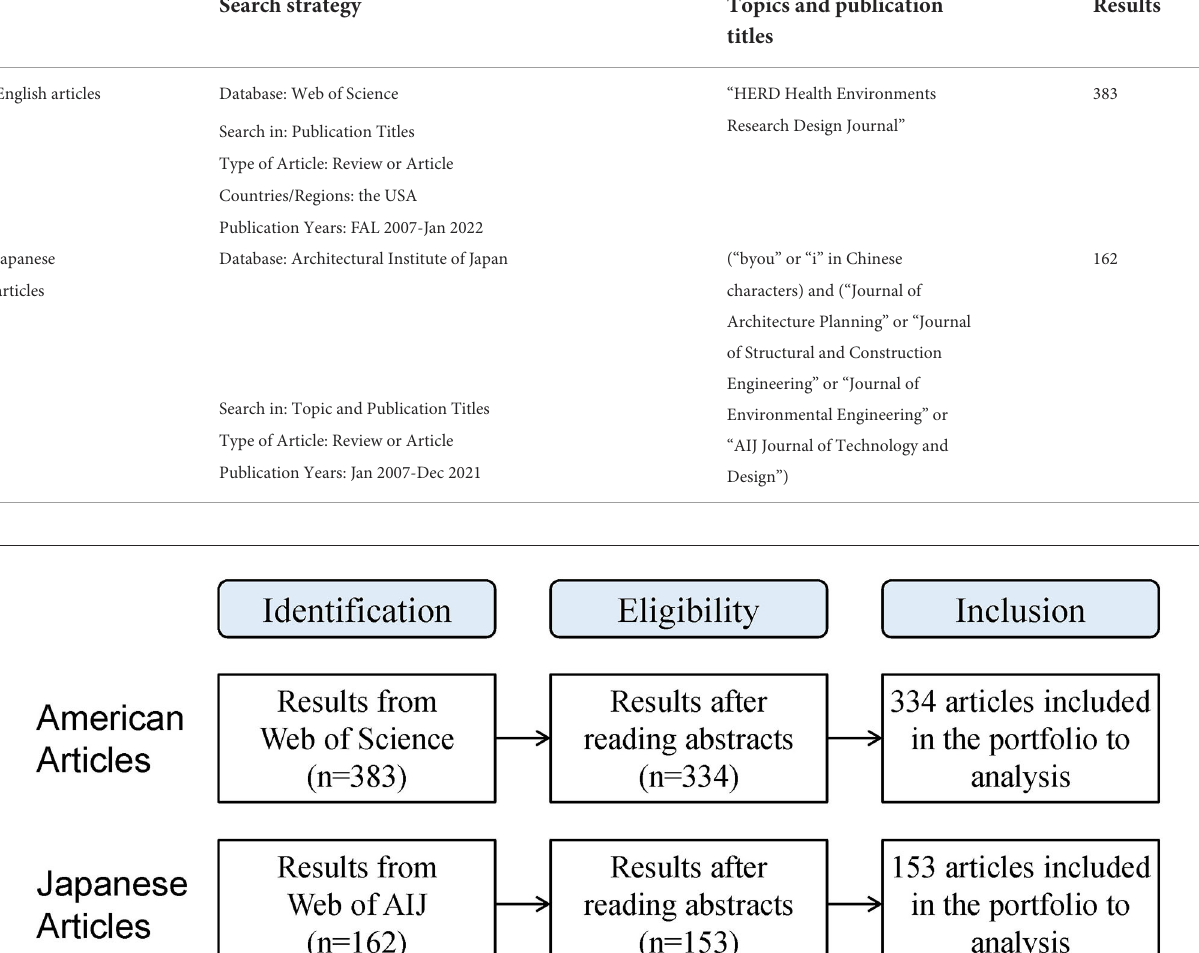
TABLE 1 Search strategies and results of the English and Japanese articles.